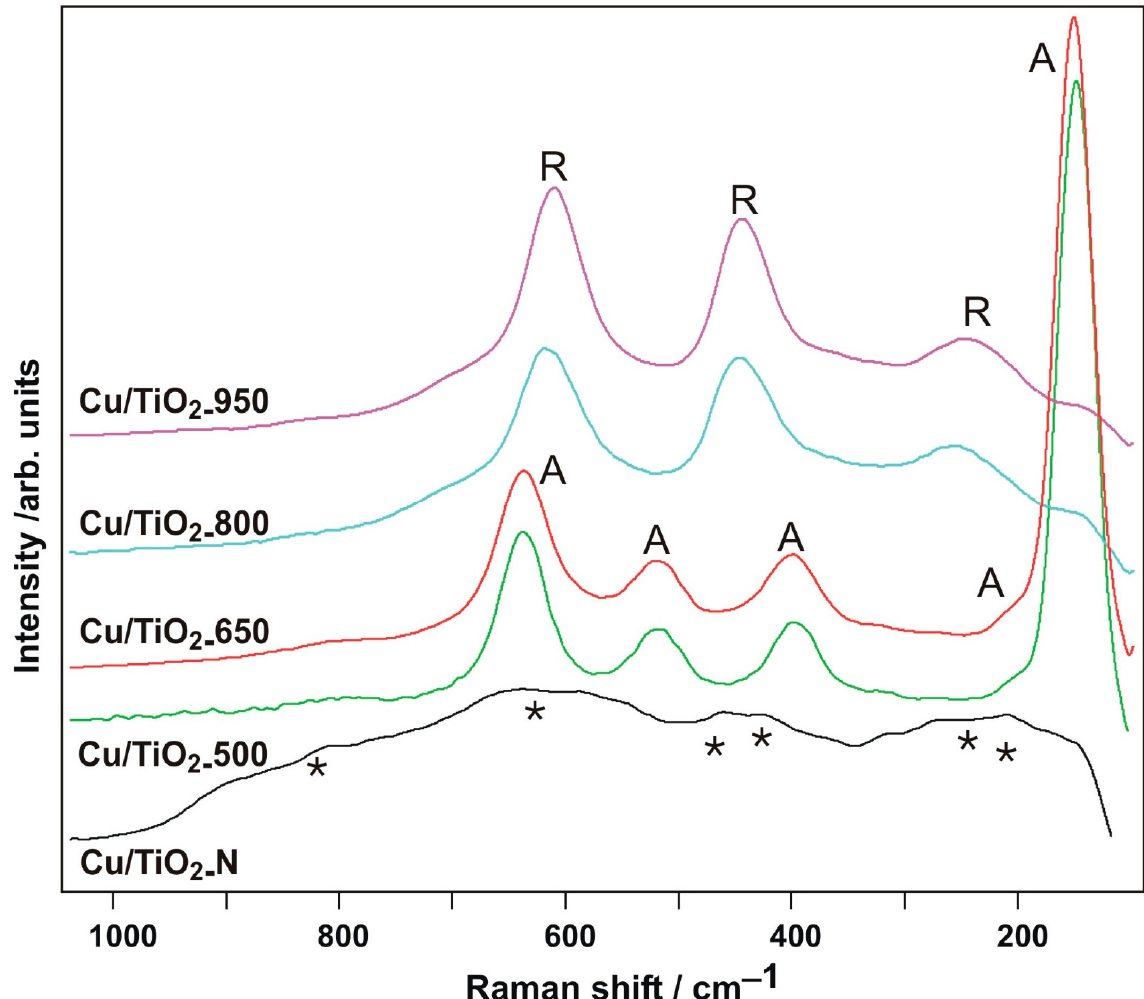
Figure 11. Raman spectra of the Cu/TiO 2 _500, Cu/TiO 2 _650, Cu/TiO 2 _800 and Cu/TiO 2 _950.